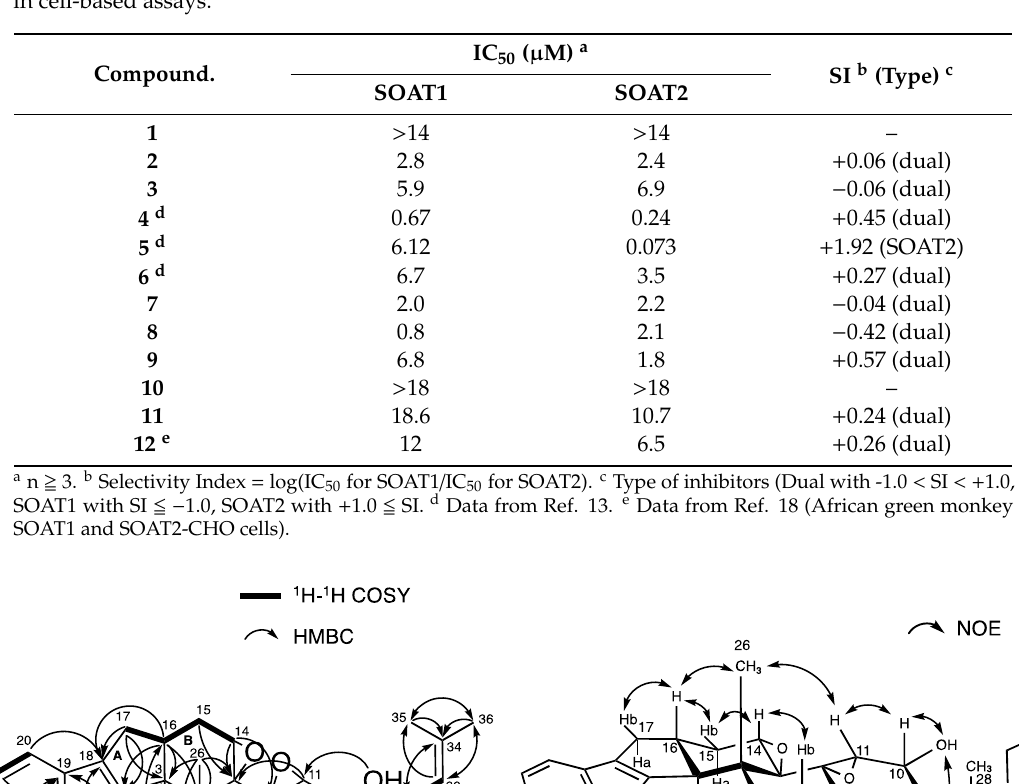
Table 3. Inhibitory activities of 1 – 12 on human sterol O -acyltransferase (SOAT)1 and SOAT2 activities in cell-based assays.